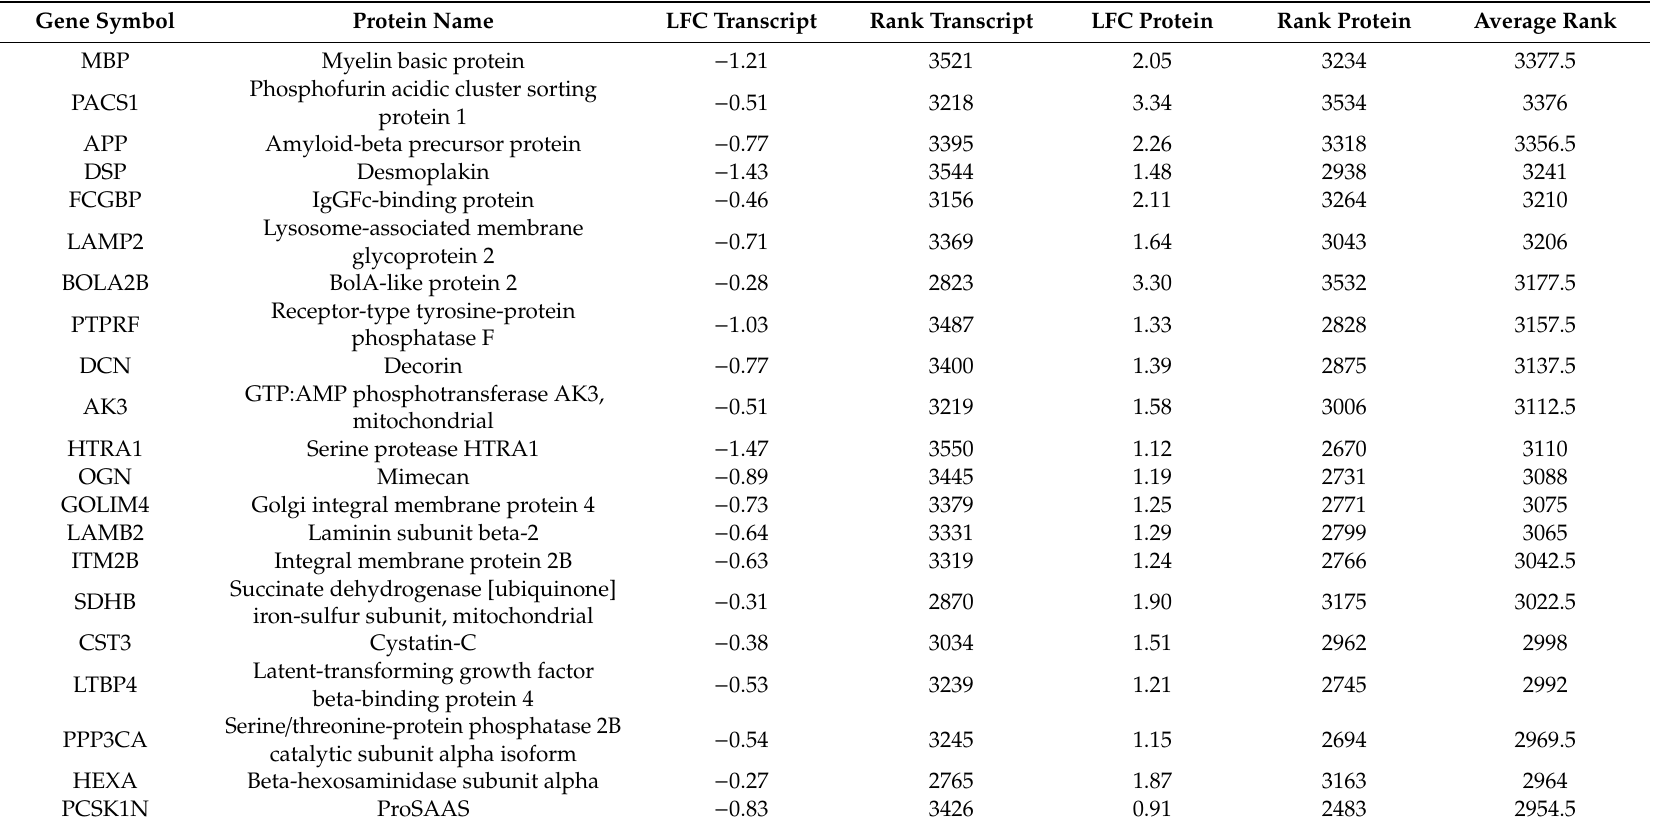
Table 1. Twenty-one of the top 100 discordantly expressed genes (positive protein LFC but negative transcript LFC) also found to be present in the published Human Plasma Peptide Atlas consisting of 1929 canonical protein sequences [28]. Shown are overlapping genes with respective LFC, rank and average rank values. Table S3C details discordantly expressed proteins also identified in the human plasma proteome reference